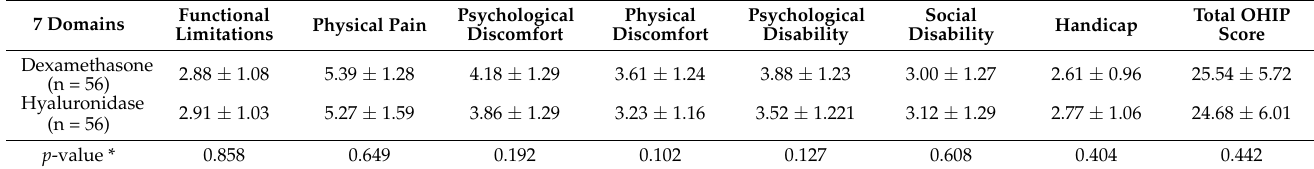
Table 4 highlights the QoL in both treatment groups. There was insignificant difference with regard to QoL in both treatment groups ( p < 0.05). Table 4. Comparison of mean score of 7 domains of OHIP-14 item in dexamethasone and hyaluronidase